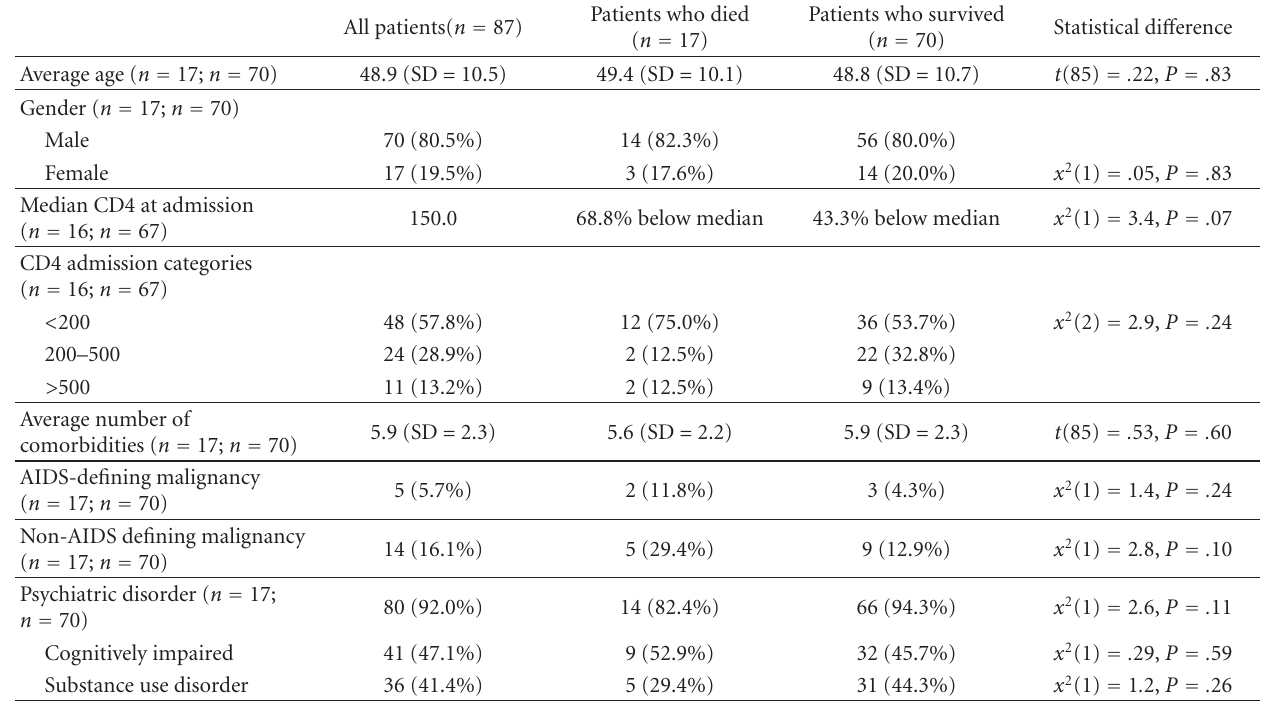
Table 2: Patient characteristics for all admissions in